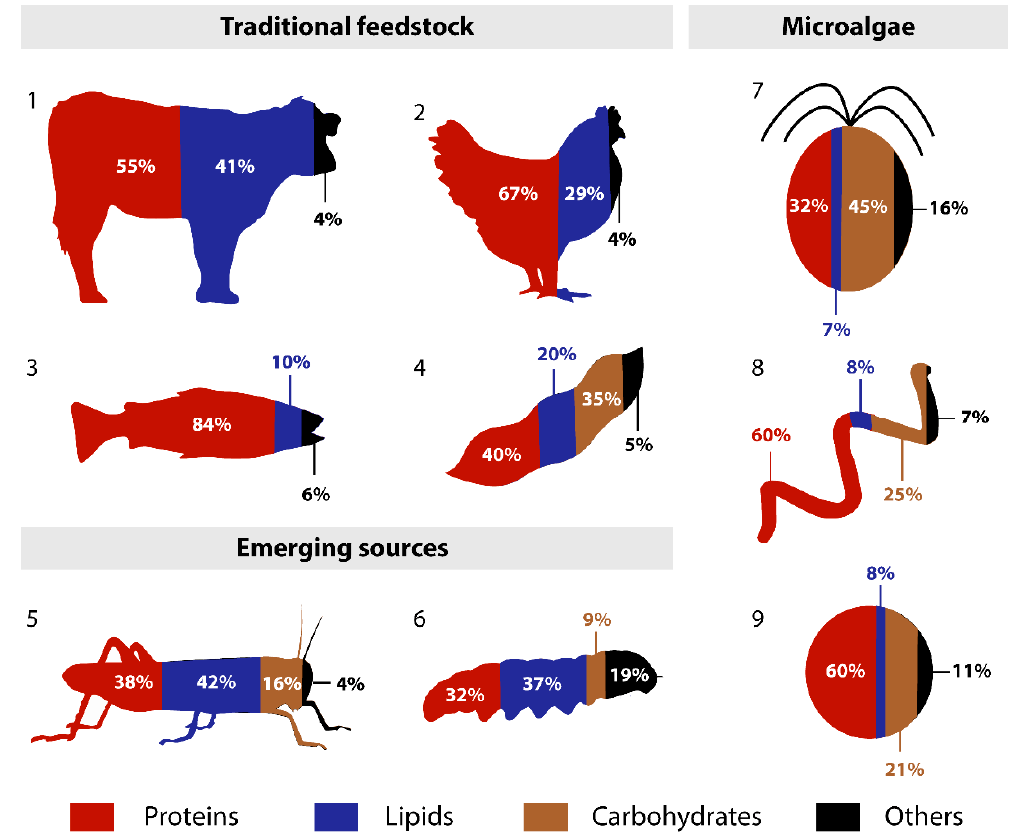
Figure 1. Illustrative comparison of the macronutritional composition (% of dry matter) for human and animal nutrition of traditional (1–4), emerging (5,6), and microalgal feedstocks (7–9). 1: Beef (FAO); 2: Chicken (USDA); 3: Fish (Bass; FAO); 4: Soybean (Seeds raw; USDA); 5: Grasshopper— Ruspolia nitidula [30]; 6: Black soldier fly prepupae— Hermetia illucens [31]; 7: Tetraselmis sp. CTP4 (Present work); 8: Spirulina (Dried; USDA)[29]; 9: Chlorella vulgaris (Allma product sheet)